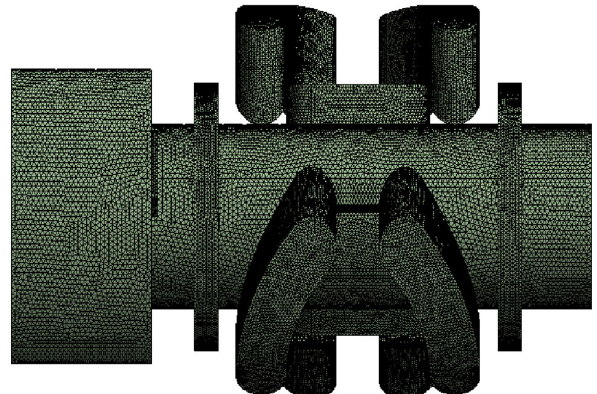
Figure 16. Internal fluid grids of regulating valve.